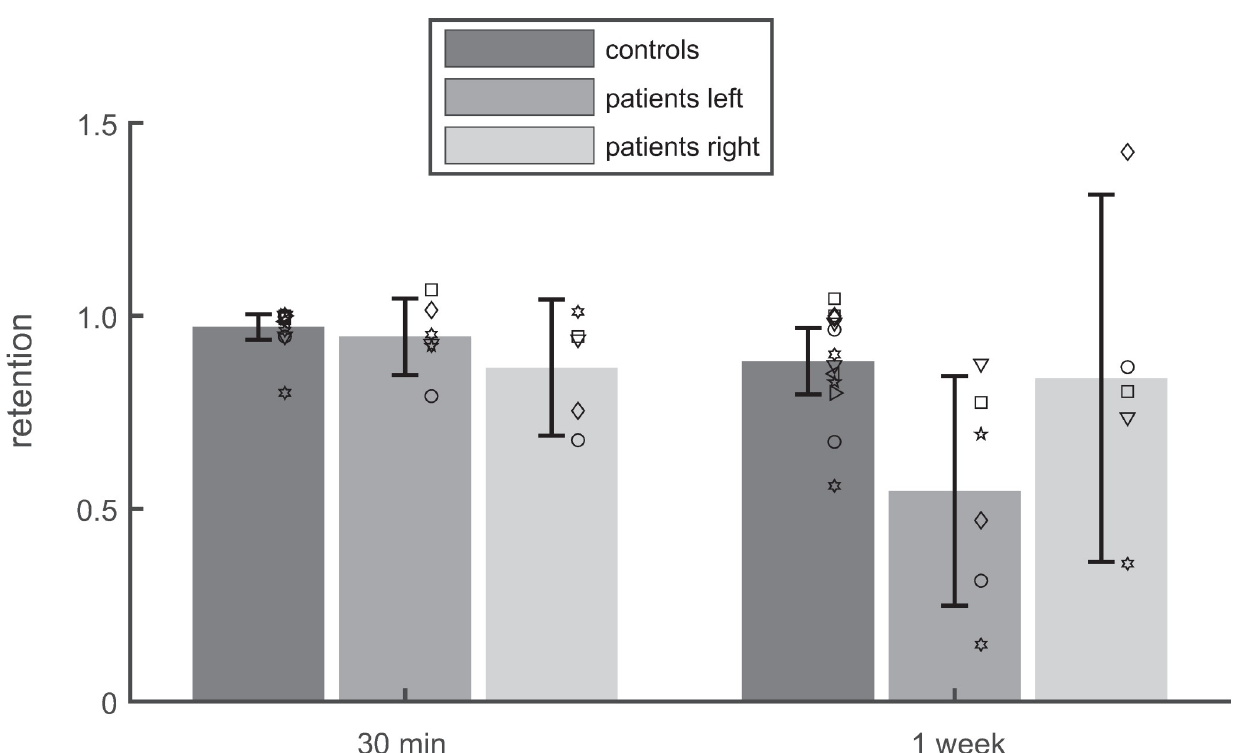
Fig 5. Retention in DILSS. Bars and whiskers show the mean and the 95% confidence interval of the mean of the retention ( % ) after 30 min and after one week; Symbols: retention of individuals. TLE-patients with lesions on the left side show smaller retention than the controls after one week but not after 30 min.